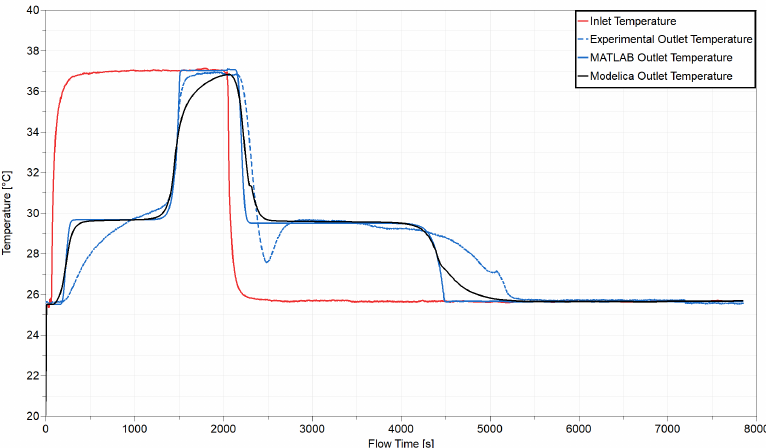
Figure 7. Comparison of experimental data with model predictions of prototype outlet